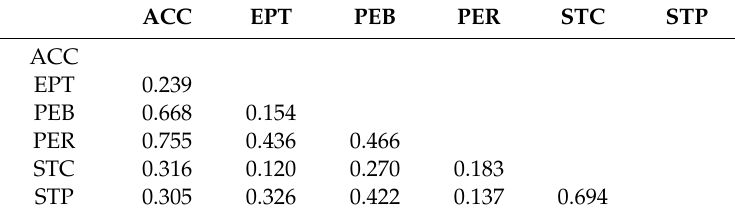
Table 4. Discriminant validity (heterotrait–monotrait ratio